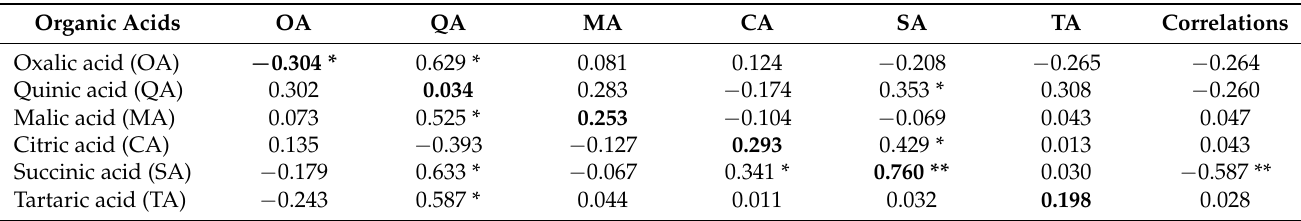
Table 4. Path coefficients on direct (bold) and indirect effects of organic acids on RL scores in the field and correlations between RL and organic acids.